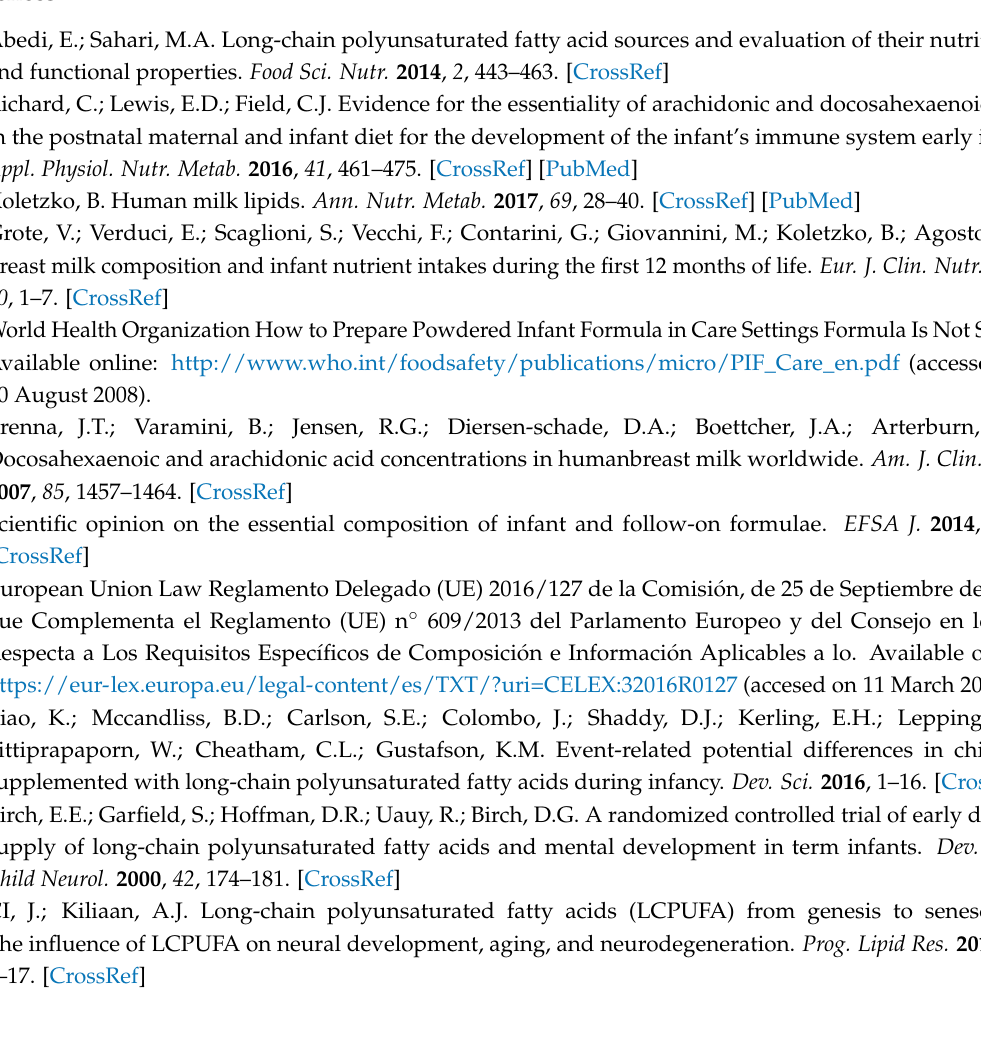
Table S1: The genetic variants studied within the FADS genes, Table S2: Fatty acid content in infant formulas, Table S3: Associations between FADS genes and fatty acid levels in infants, Table S4: Fatty acids and enzymatic indexes according to infant SNPs and study